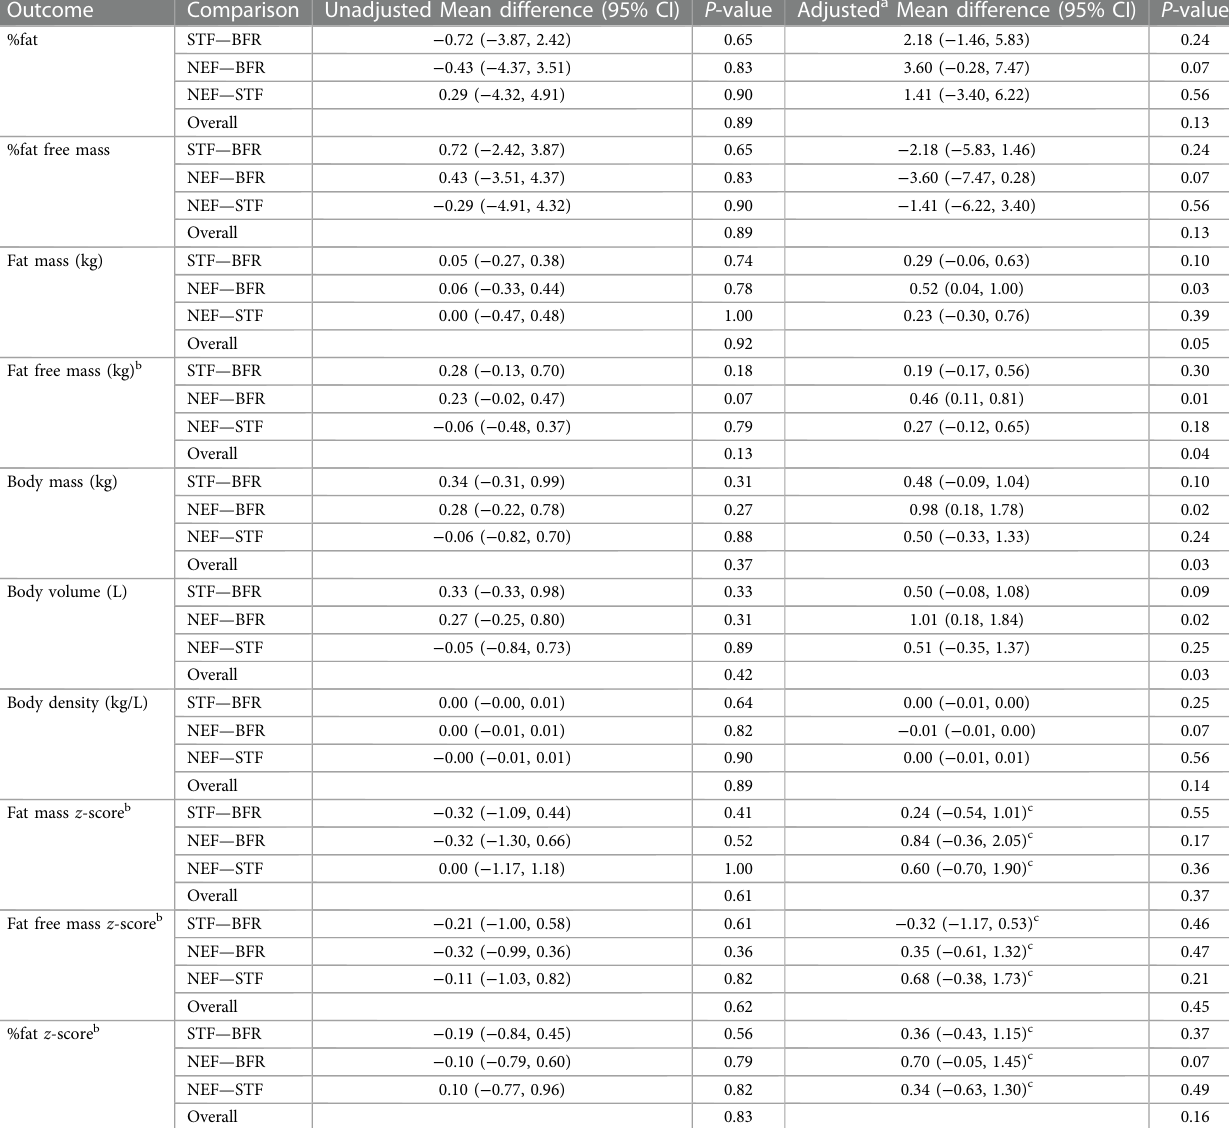
TABLE 6 Body Composition of all groups at 120 days of